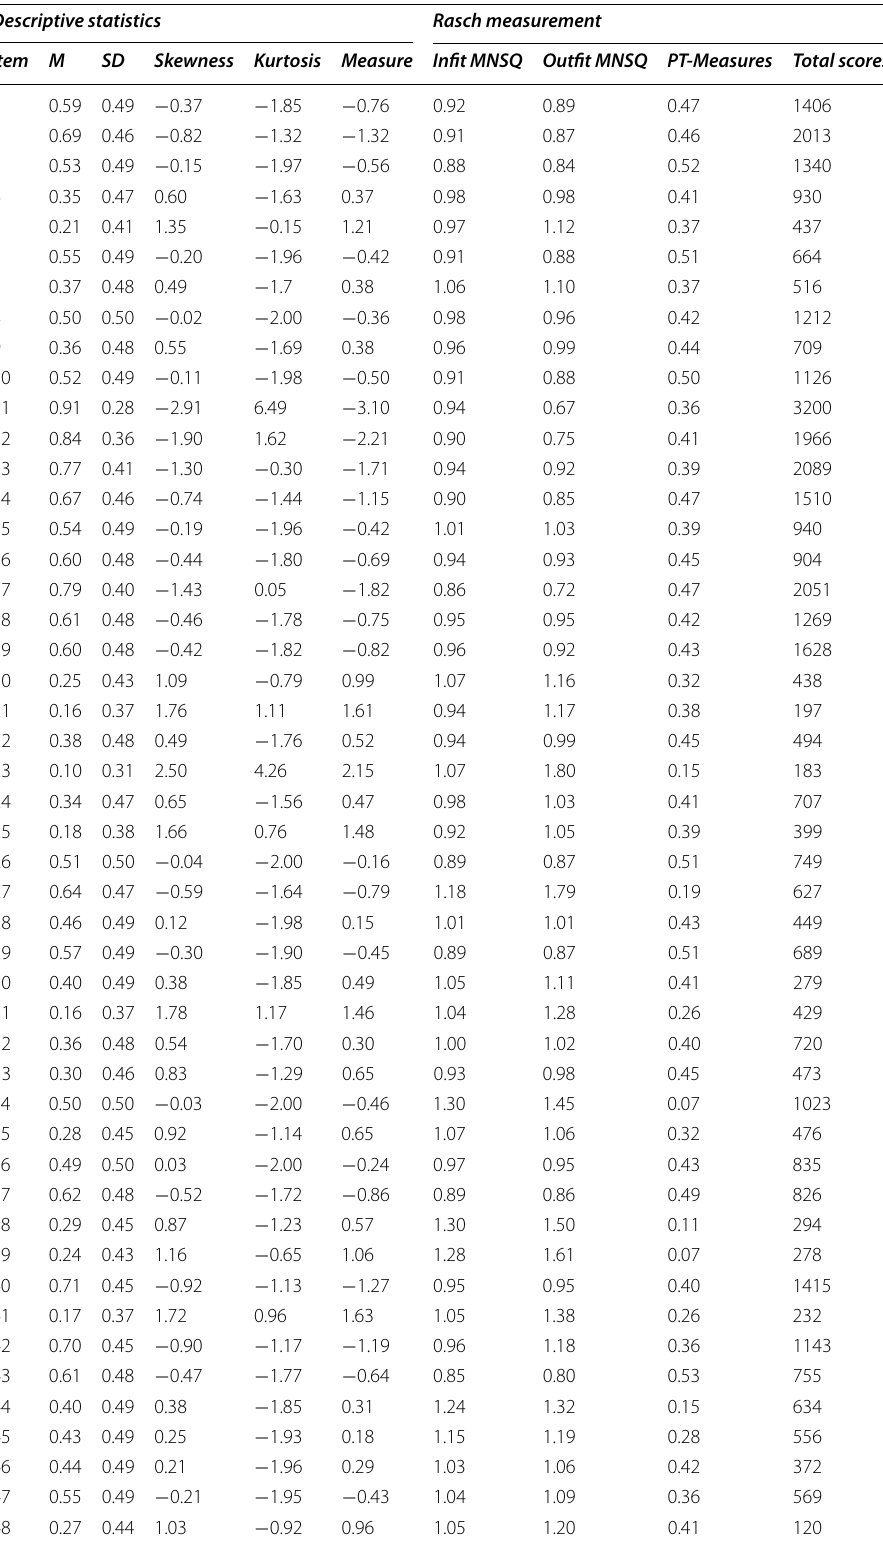
Table 19 Results of descriptive statistics analysis and Rasch measurement (IUUESEE 2018) Descriptive statistics Rasch